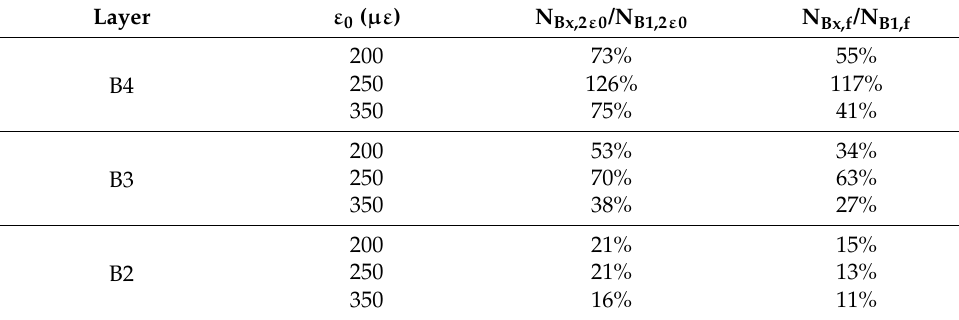
Table 10. Percentage increase of load repetitions compared to